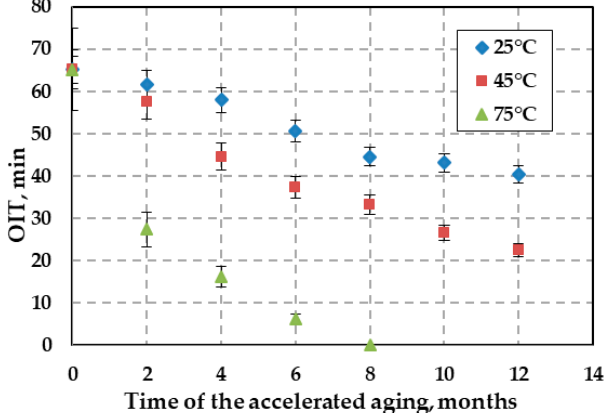
Figure 5. Variation in oxidation induction time (OIT) of the high density polyethylene (HDPE) geogrid sample with time in leachate at three temperatures: 25 °C, 45 °C, and 75 °C.